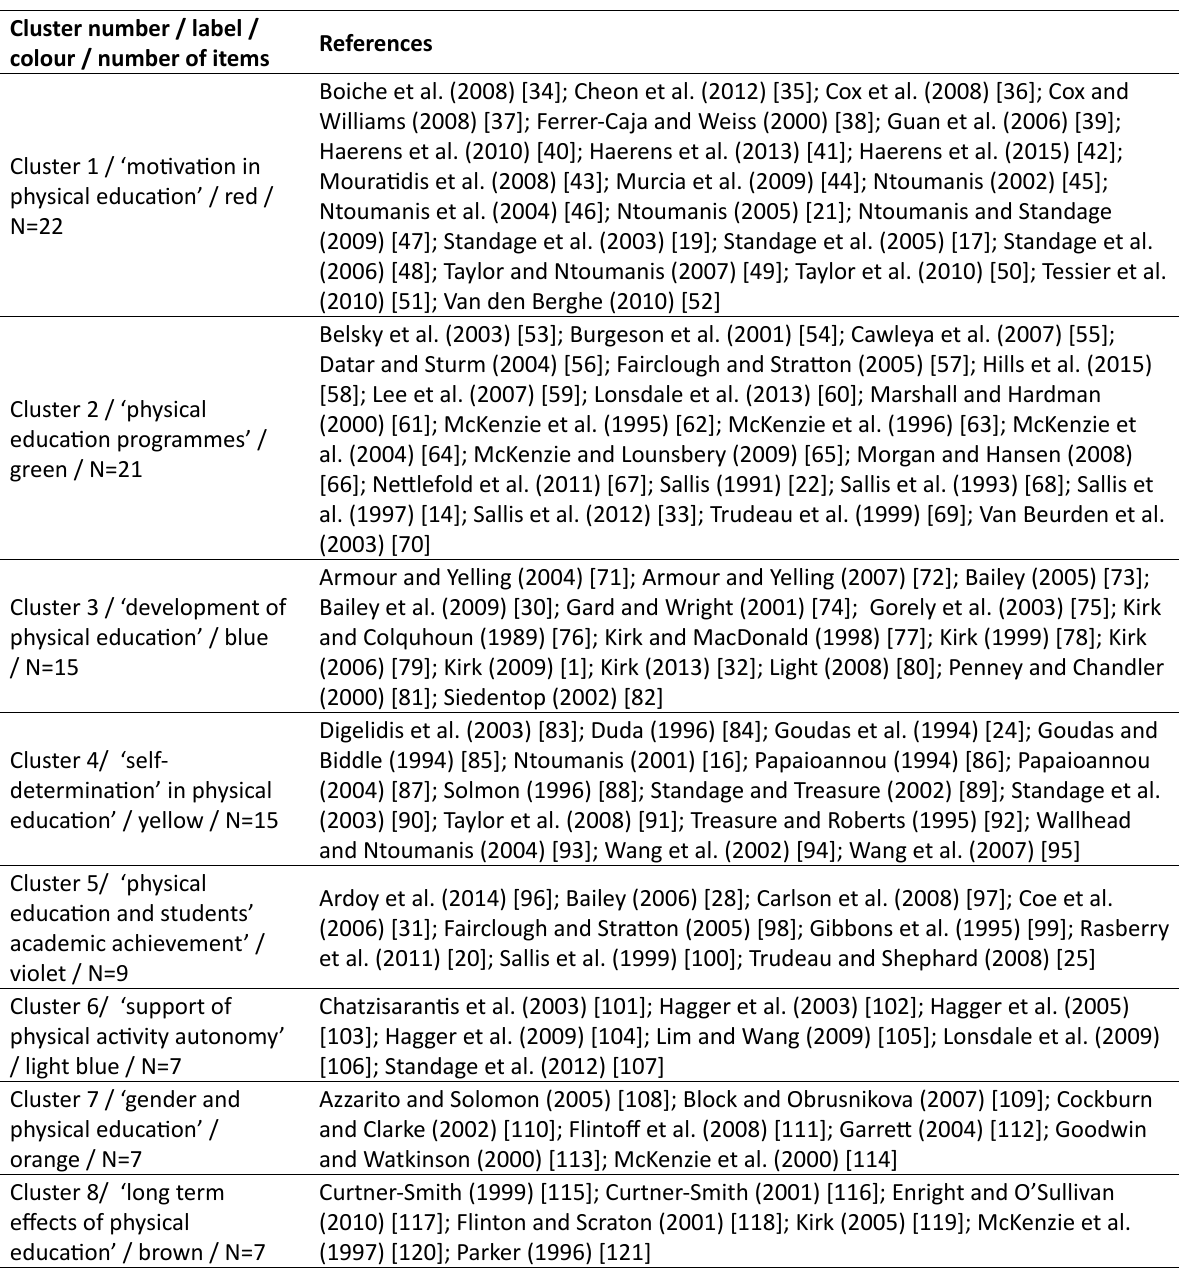
Table 2. Clusters of core references in physical education research Cluster number / label